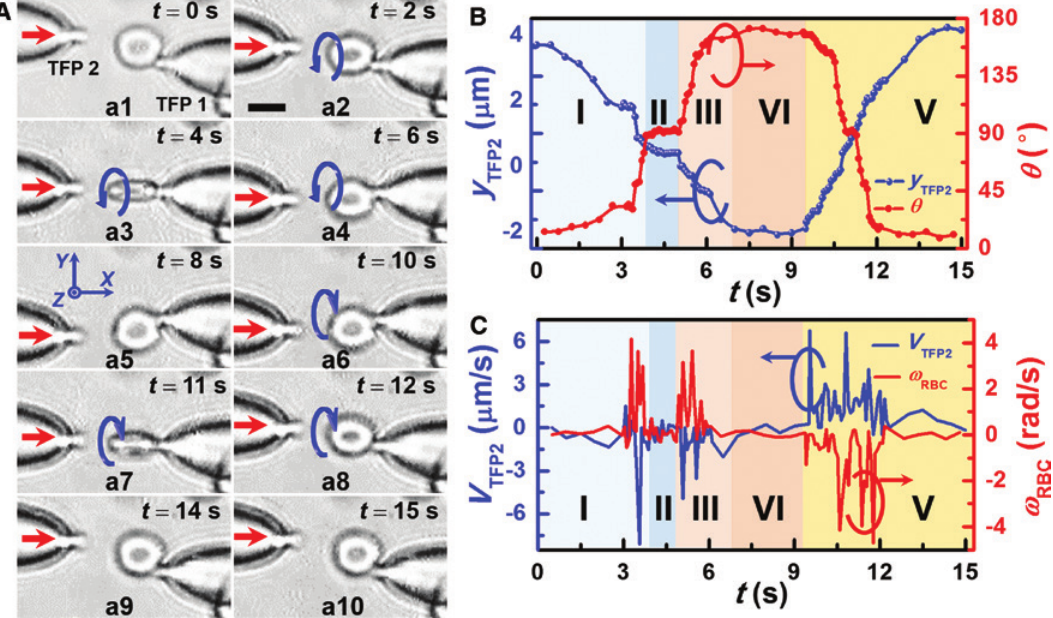
Figure 2: RBC rotation around the x axis. (A) Optical microscopic images for rotating an RBC around the x axis. Scale bar: 5 μ m. (B) Calculated y and θ in the rotation process. (C) Calculated V TFP2